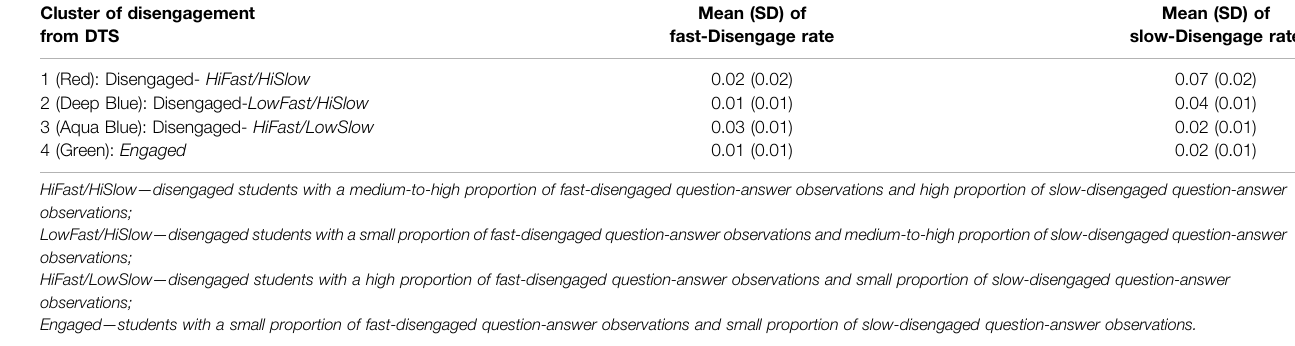
Mean (SD) of slow-Disengage rate